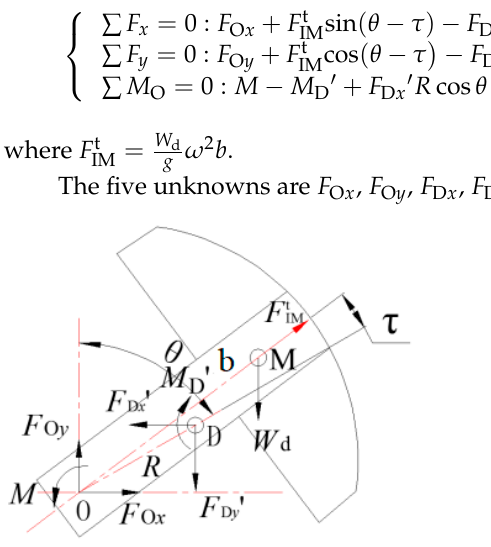
Figure 10. Force analysis of the large crank balance weight.